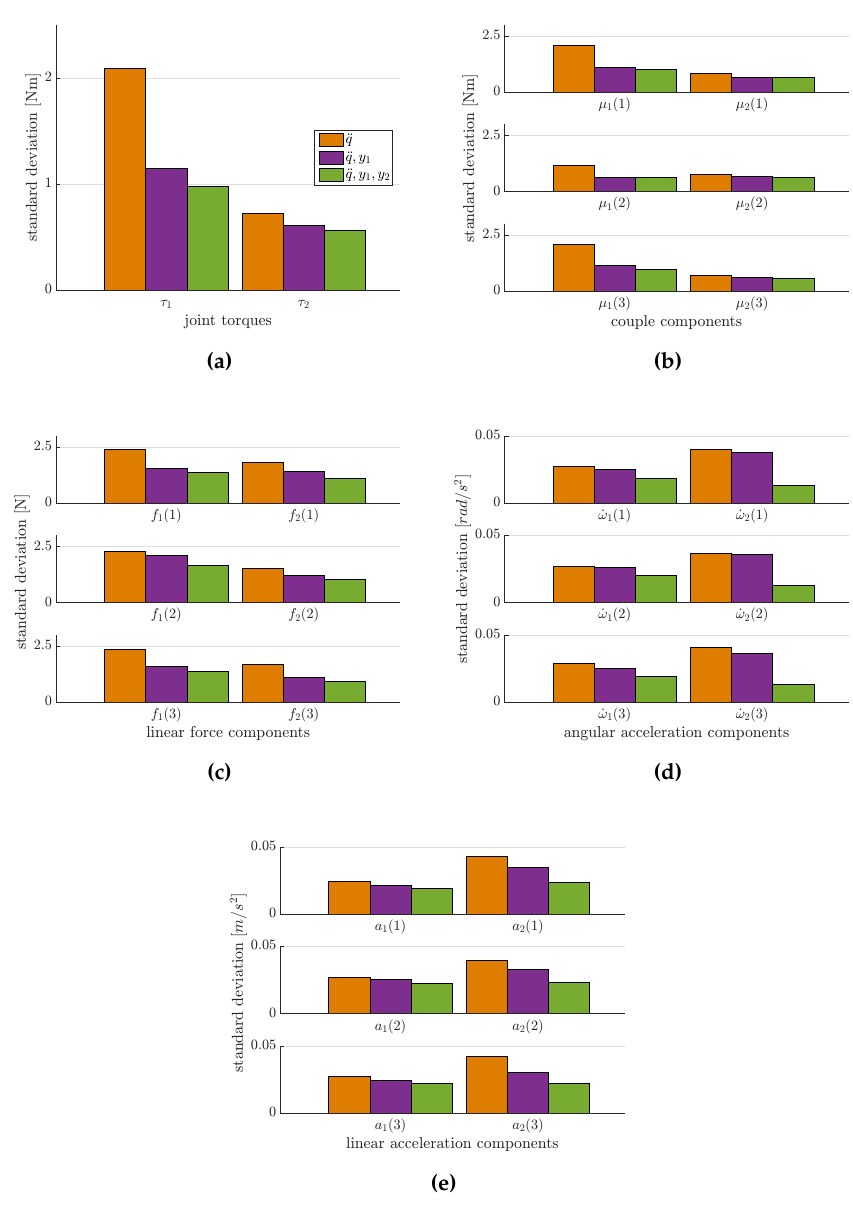
Figure 6. Considering three MAP computation cases with one sensor ( y = ¨ q ), two sensors ( y = ¨ q , y 1 ), and all sensors ( y = ¨ q , y 1 , y 2 ), we computed standard deviation of ( a ) Σ τ Σ f 2 | y for both angular ( µ ) and linear ( f ) components; ( d , e ) linear ( a ) components. These plots show that when increasing the number of sensors in the analysis, the standard deviation of each variable estimated in the vector µ d | y progressively